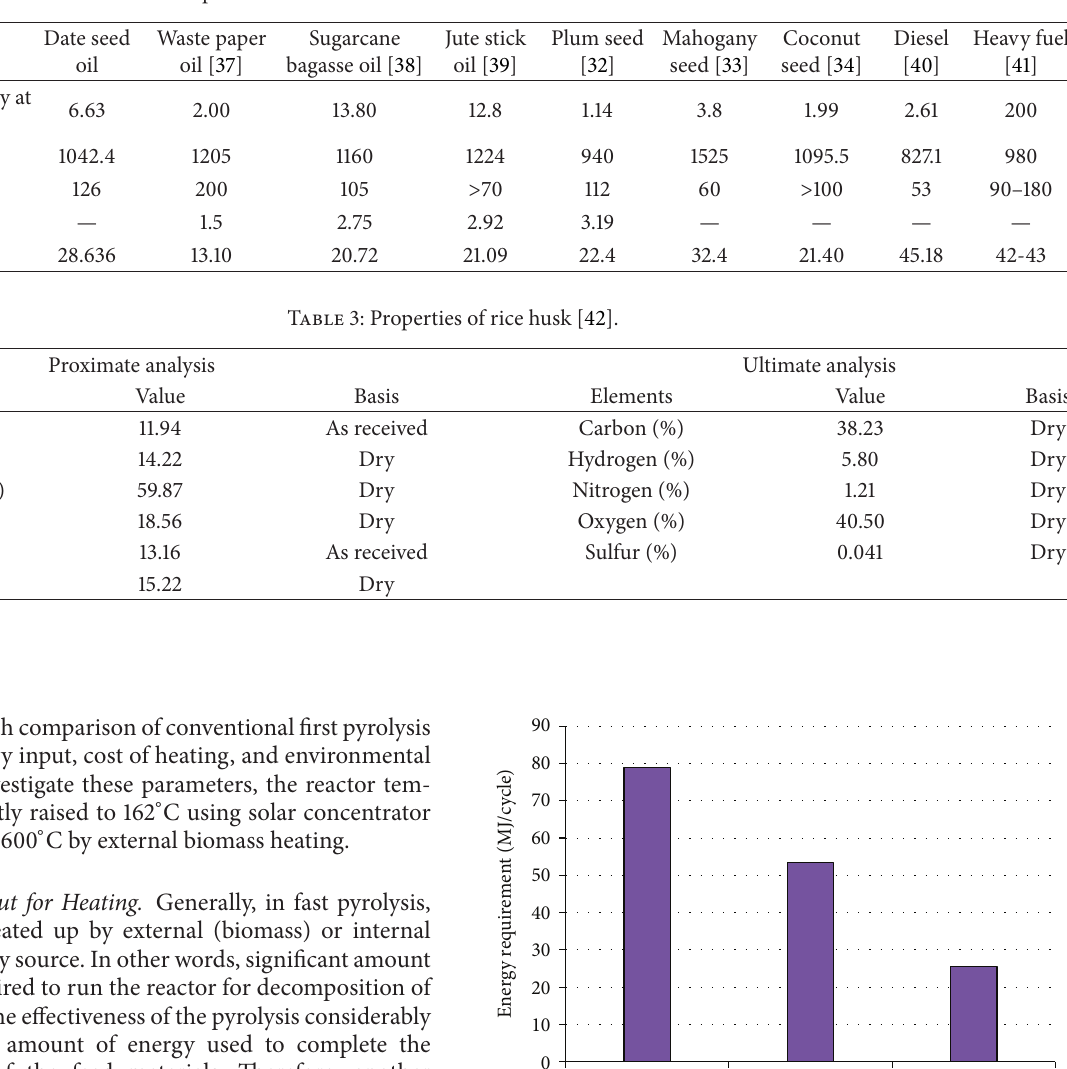
Table 2: Comparison of date seed oil with other biomass derived oils and diesel fuel.